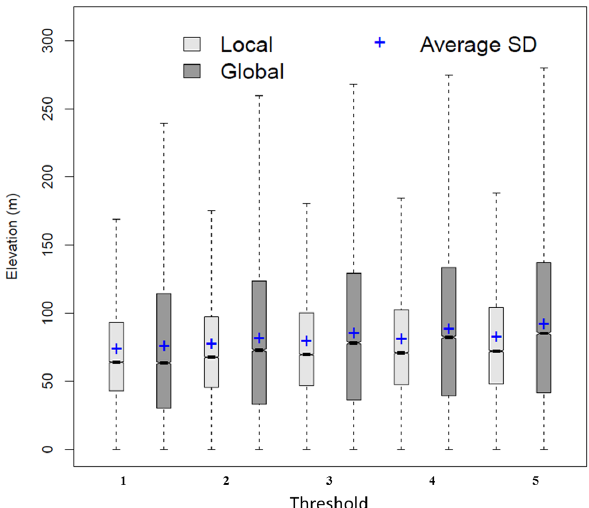
Figure 6. The standard deviation (SD) in elevation within the elevation-based geo-located SUs derived using different values of area threshold. On each box, the central mark (notch) is the median ( q 2), the edges of the box plot are the 25th ( q 1) and 75th ( q 3) per- centiles, and the whiskers extend to the most extreme data points ( q 3 + 1 . 5 x interquartile range ( q 3 − q 1) and q 1 − 1 . 5 x interquartile range ( q 3 − q 1); outliers are not considered).